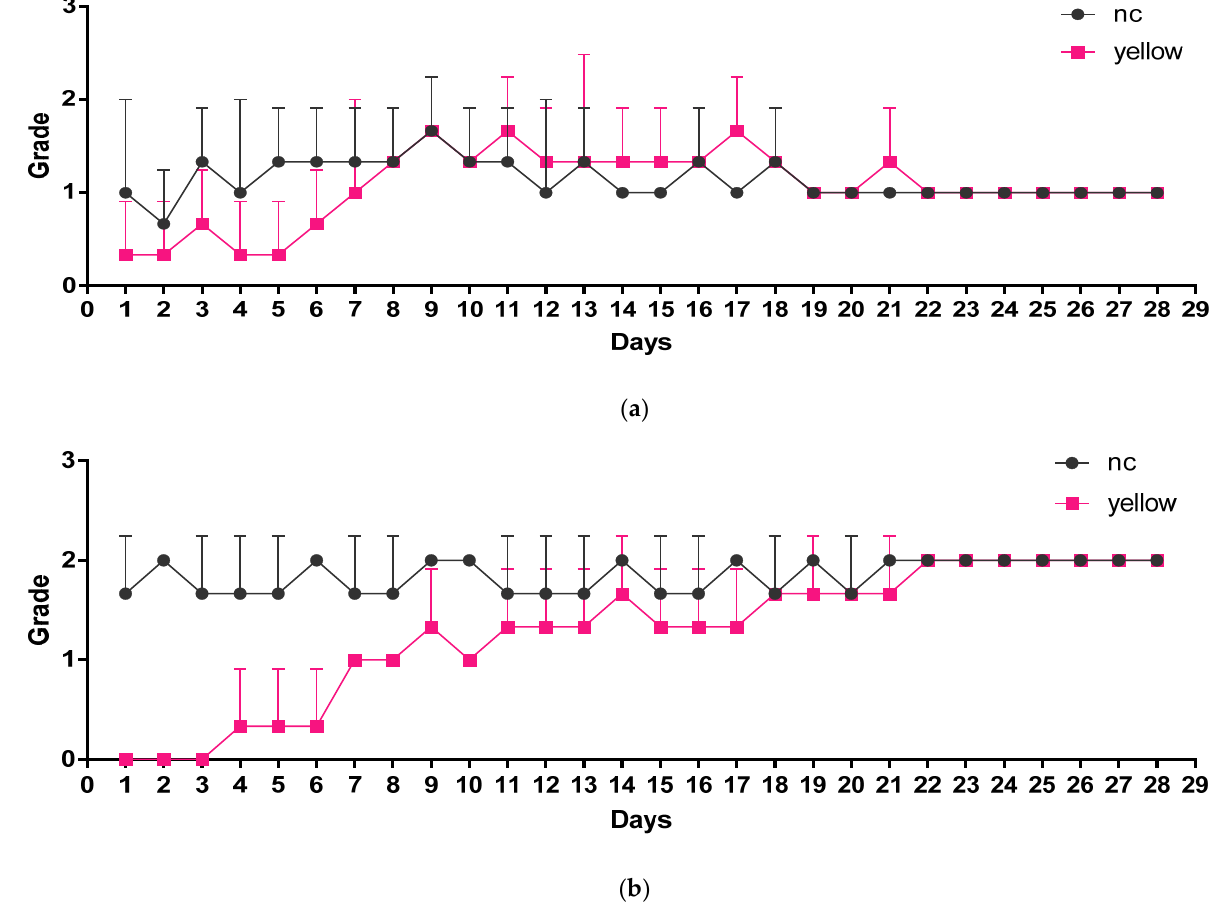
Figure 5. Feeding situation of crucian carp within 28 days after being stimulated by the bionic robot fish. ( a ) Response time; ( b ) Food consumption. Values are represented as mean ± SD of data from triplicates per treatment ( n = 5).